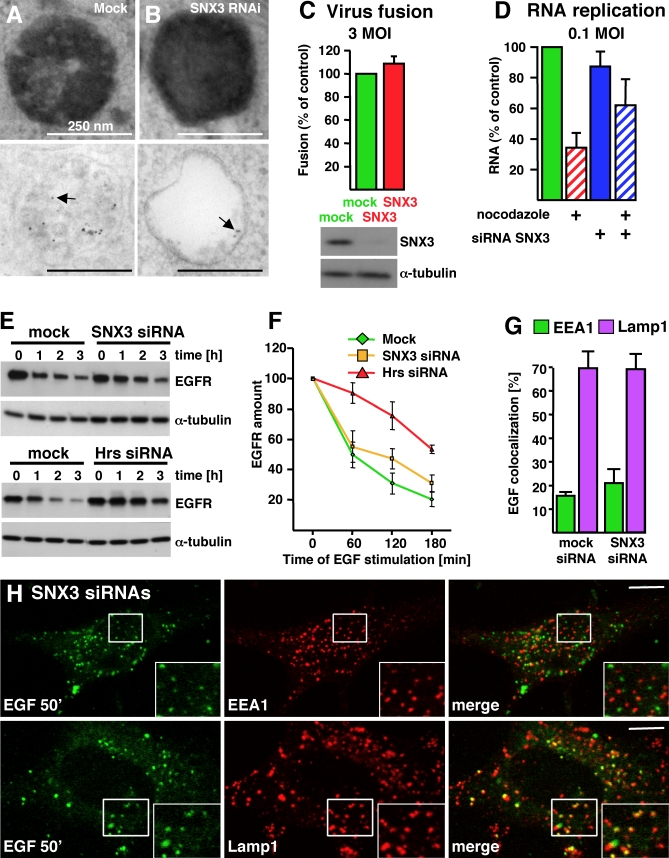
SNX3 Silencing Inhibits Membrane Formation within MVBs but Does Not Affect EGFR Early-to-Late Endosomal Transport and Degradation(A) The ECV/MVB content of mock-treated HeLa cells was labeled with endocytosed HRP [22,46]. Samples were processed for plastic embedding after HRP cytochemical detection, and analyzed by electron microscopy. The micrographs show representative high-magnification views of individual HRP-containing structures (upper panel). In separate experiments, the ECV/MVB content was labeled with 5-nm proteinA-gold endocytosed for 30 min at 37 °C (lower panel).(B) As in (A), but cells were treated with SNX3 siRNAs.(C) SNX3 siRNA or mock-treated HeLa cells were incubated with 3 MOI Dil-labeled VSV and viral fusion was monitored as in Figure 2D (inset: SNX3 down-regulation in cells treated with SNX3 siRNAs).(D) HeLa cells were treated with SNX3 siRNAs or mock-treated, and then microtubules were depolymerized or not with 10 μM nocodazole. Then, cells were infected with 0.1 MOI VSV, and RNA replication was quantified as in Figure 2C.(E and F) HeLa cells treated with SNX3 siRNAs, Hrs siRNAs, or mock-treated were stimulated with EGF and analyzed as in Figure 1A. Blots were scanned and the quantification is shown in (F).(G) Individual endosomes containing both EGF and EEA1 or Lamp1 were counted in SNX3 siRNA-treated cells (see [H] below) and in control cells (Figure S8A). Values are expressed as a percentage of the total number of EGF-containing endosomes in each category (>10 cells per experiment).(H) EGF-biotin coupled to streptavidin-AlexaFluor 488 was endocytosed as in Figure 1C and 1D in cells treated with SNX3 siRNA. Cells were analyzed by immunofluorescence with the indicated antibodies. Insets in the lower right are a magnification of the regions shown in the boxes.In (C and D) and (F and G), each condition is the mean of at least three independent experiments; standard errors are indicated.(A and B) Scale bar indicates 0.25 μm; (H) scale bar indicates 10 μm.